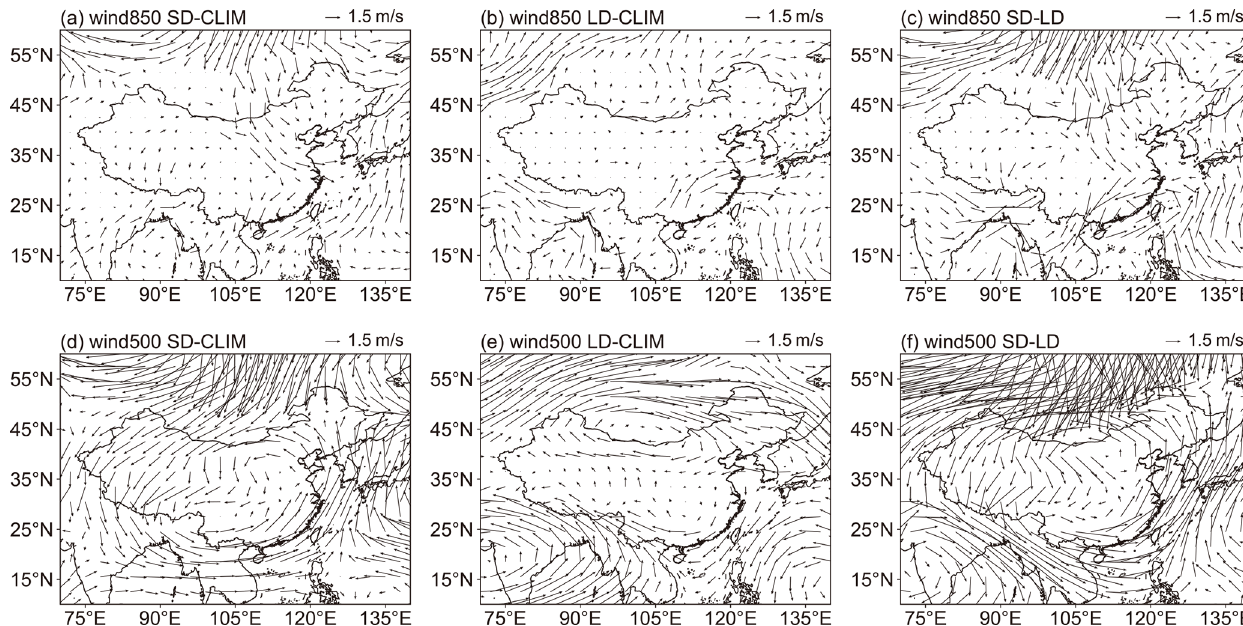
Figure 7. Composite differences in DJF mean winds at 850hPa (ms − 1 ) (a – c) and 500hPa (ms − 1 ) (d – f) between 2015/16 SD El Niño and climatological mean (1950–2017) (a, d) , 1986/87 LD El Niño and climatological mean (b, e) and 2015/16 SD El Niño and 1986/87 LD El Niño (c, f) from the EAR5 reanalysis data. The data were detrended over